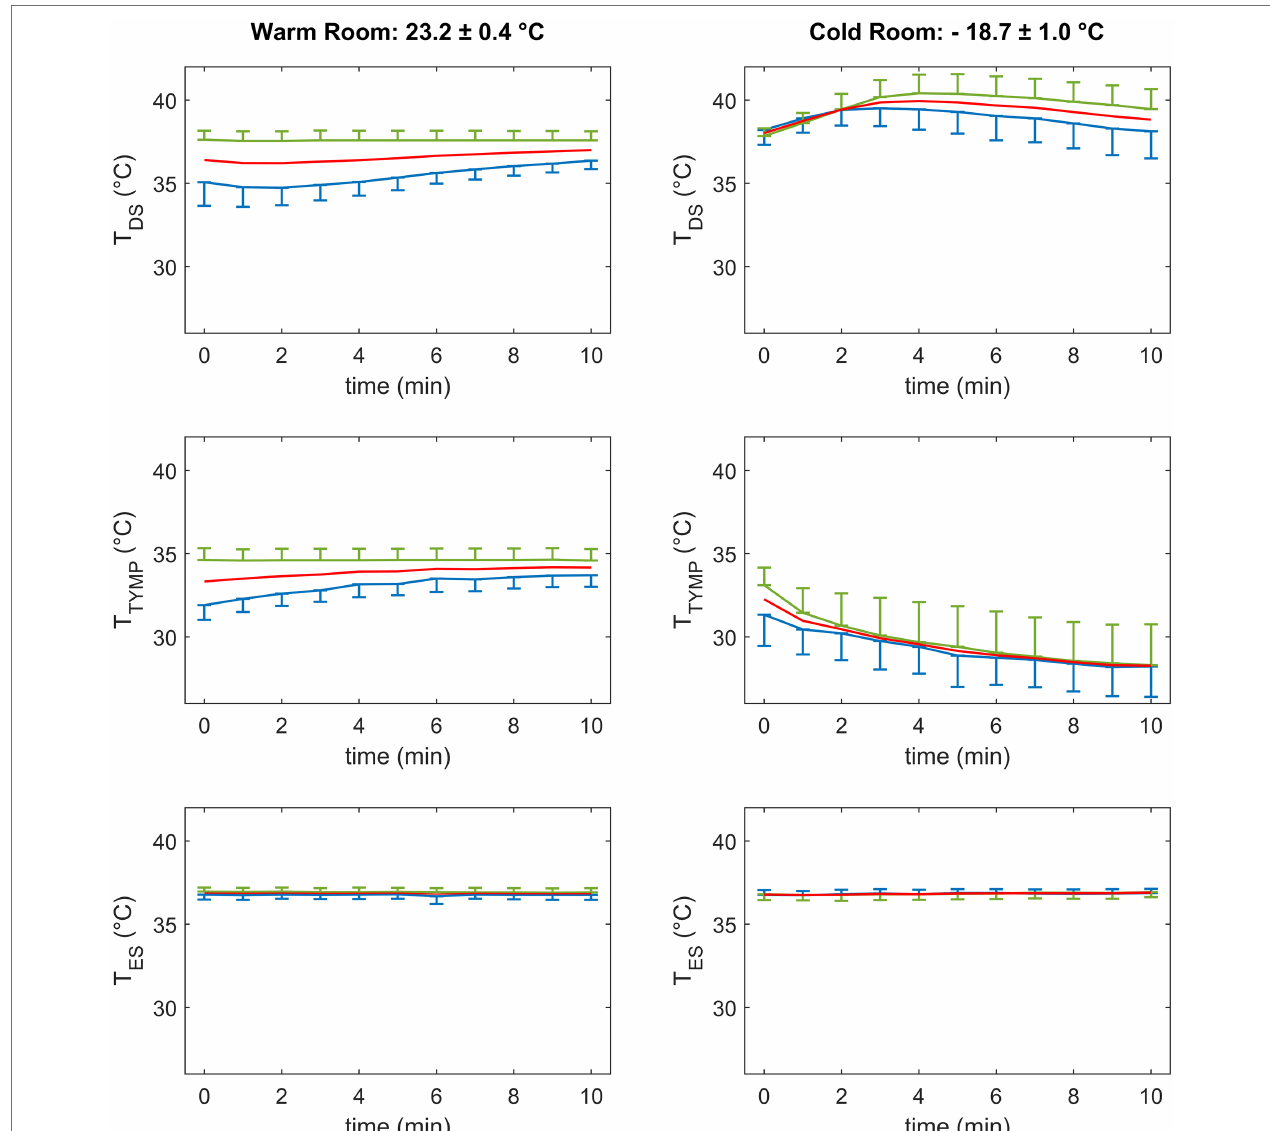
FIGURE 3 | Time course of average temperature values measured by the forehead double sensor (T DS , upper panels), the tympanic sensor (T TYMP , central panels), and the esophageal sensor (T ES , bottom panels) in the warm (left) and cold (right) room settings in the overall population (red) and in group A (exposure to cold followed by warm room setting, blue) and group B (exposure to warm followed by cold room setting, green). Data are mean and standard